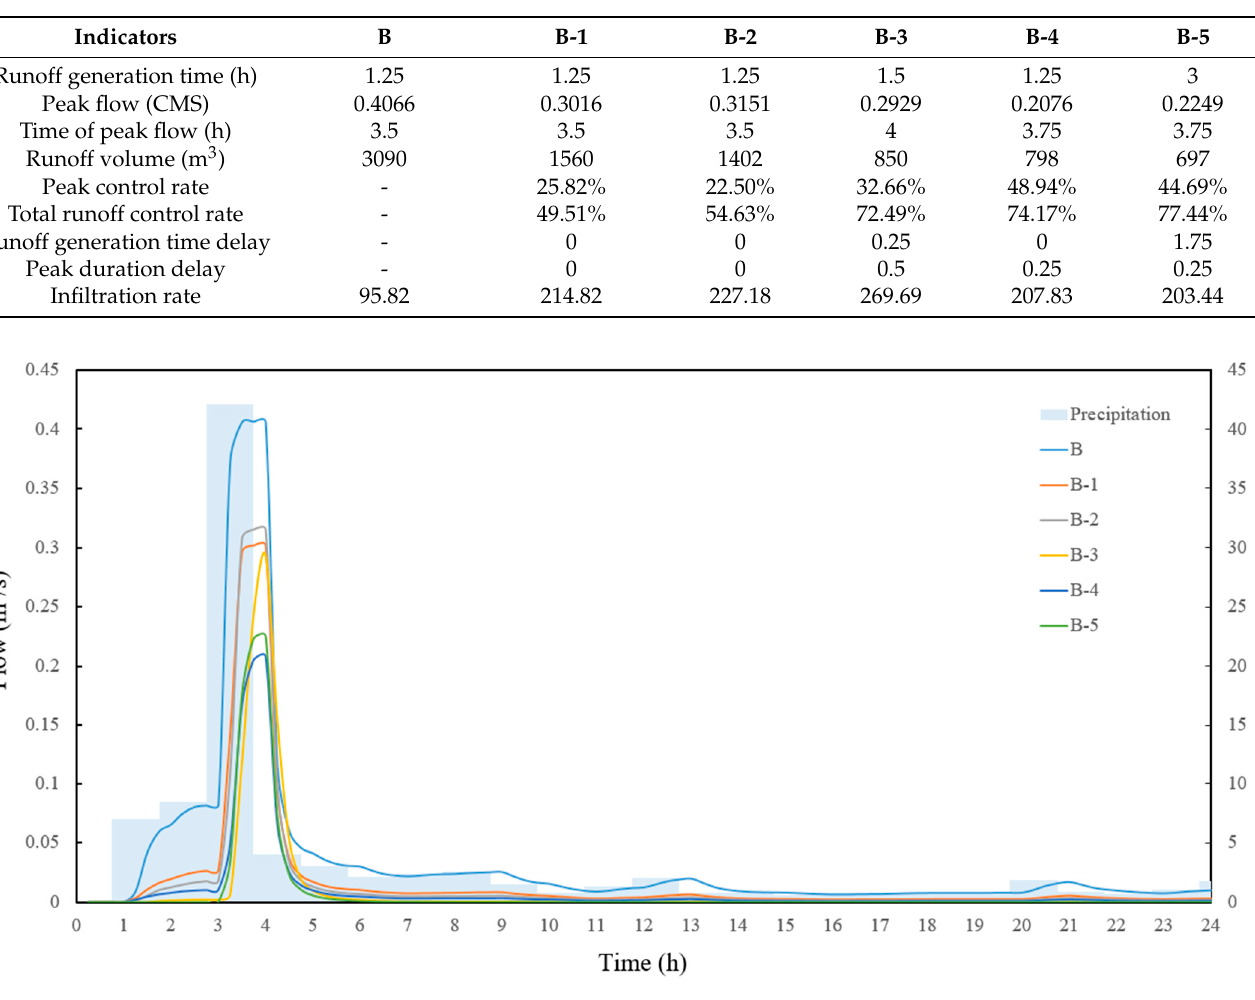
Figure 8. Runoff process in block mode residential areas under rainfall with a return period of 2 years.